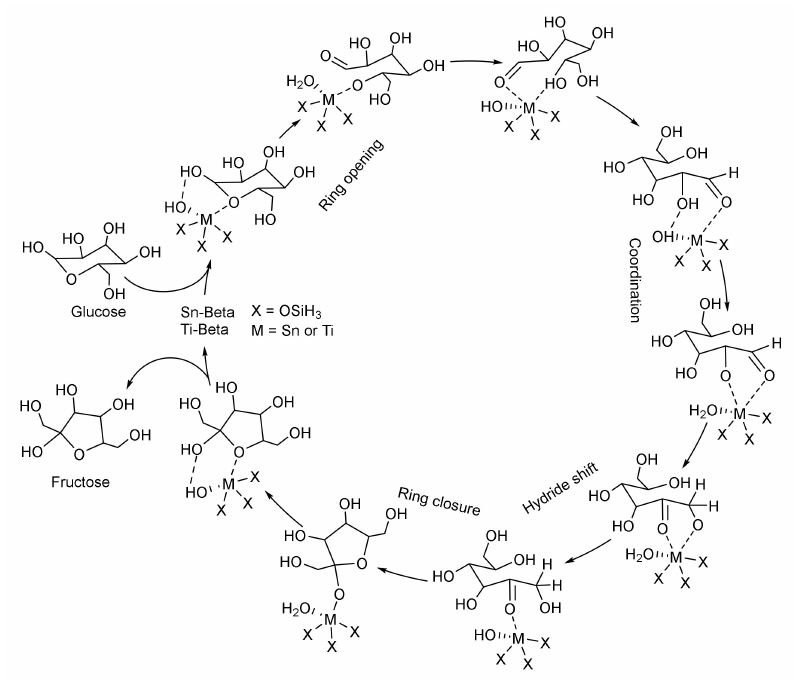
Figure 8. Mechanism of the glucose-to-fructose isomerization catalyzed by open site of Sn-Beta or